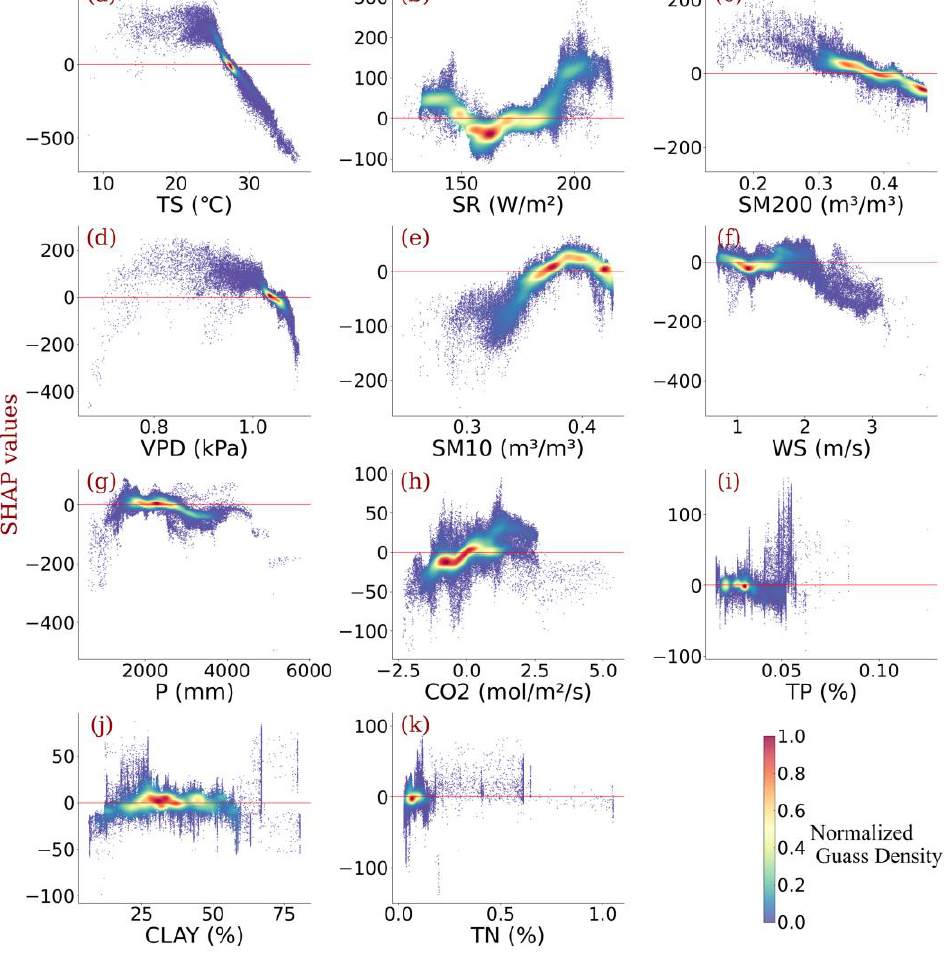
Figure A1. SHAP dependence plots depicting the SHAP values along the gradient of ( a ) TS, ( b ) SR, ( c ) VPD, ( d ) SM200, ( e ) SM10, ( f ) WS, ( g ) CO 2 , ( h ) P, ( i ) CLAY, ( j ) TN, and ( k ) TP. The lateral axis indicates the gradient of variable values. The vertical axis indicates the magnitude of the SHAP main value. Positive SHAP values indicate the positive force on NPP output while negative SHAP values indicate the opposite. The colors indicate the density. SHAP values units: g C/m².